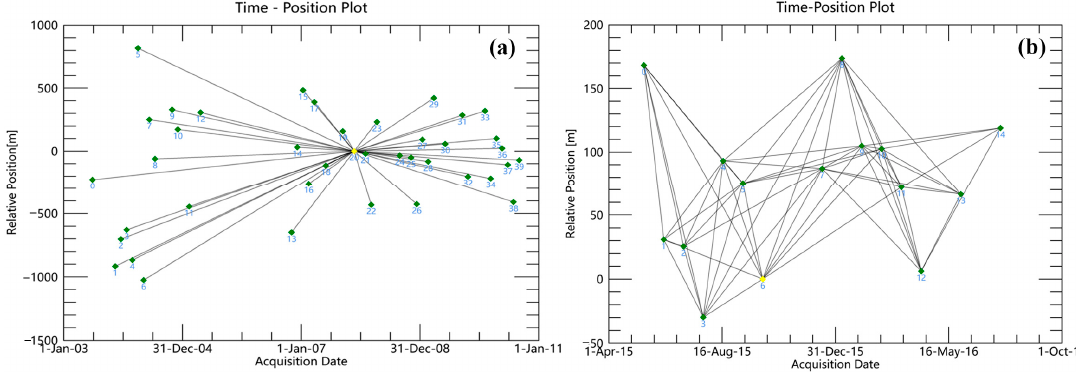
Figure 3. Spatial-temporal baselines of the generated interferograms: ( a ) Envisat PSI analysis; and ( b ) Sentinel-1A SBAS analysis. Each dot represents an image, and each line represents an interferogram.